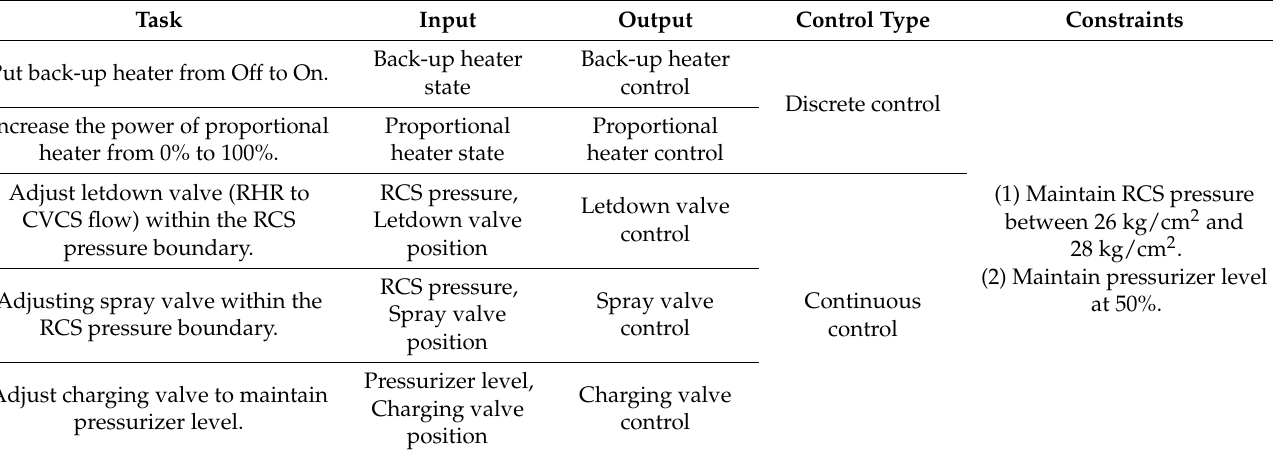
Table 3. Simplified operational task for cold shutdown operation.